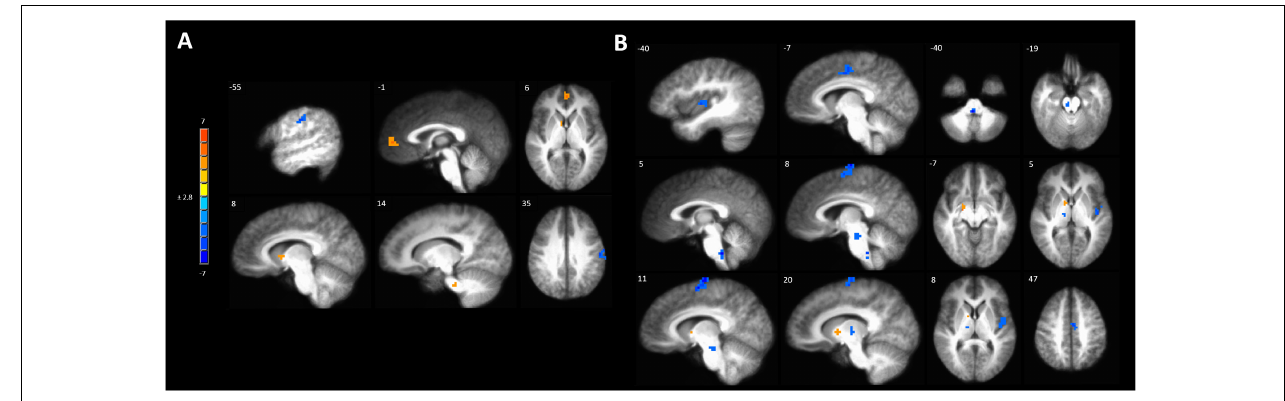
FIGURE 5 | Activations to painful mechanical stimuli in the hyperalgesic zone were modulated by tDCS. (A) Anodal compared to sham tDCS (red, anodal > sham, blue sham > anodal); (B) Cathodal compared to sham tDCS (red, cathodal > sham, blue sham > cathodal). Maps are voxel-wise threshold of p ≤ 0.005, cluster extent corrected. Coordinates are according to the Talairach atlas.